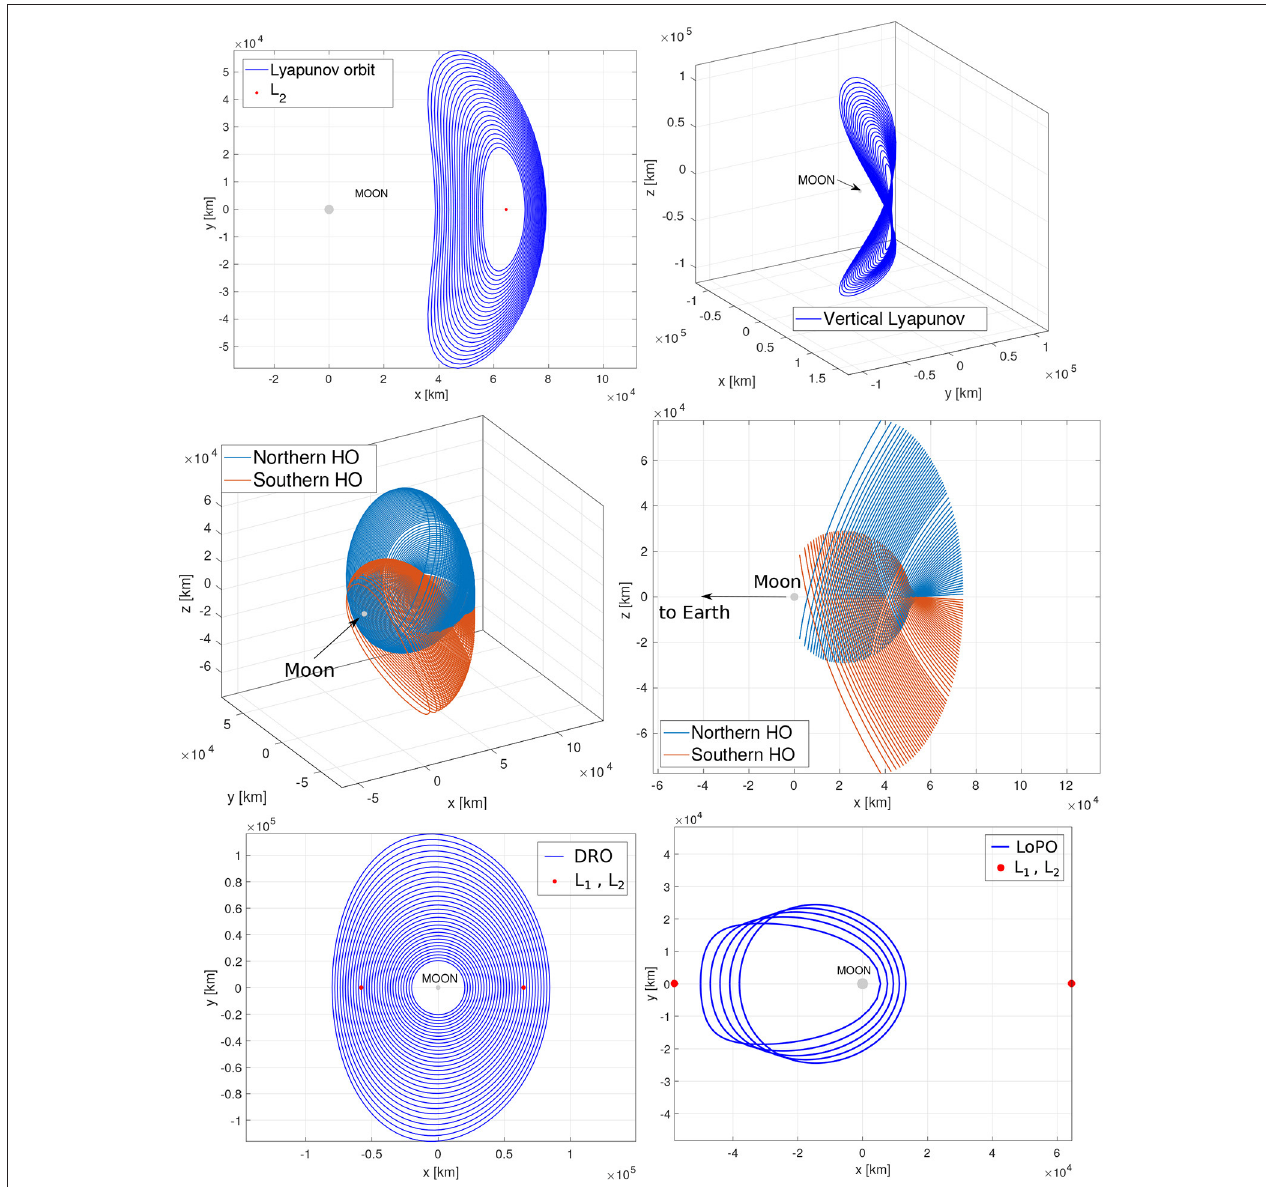
FIGURE 2 | Libration point orbit families, represented in the Moon-centered CRTBP reference